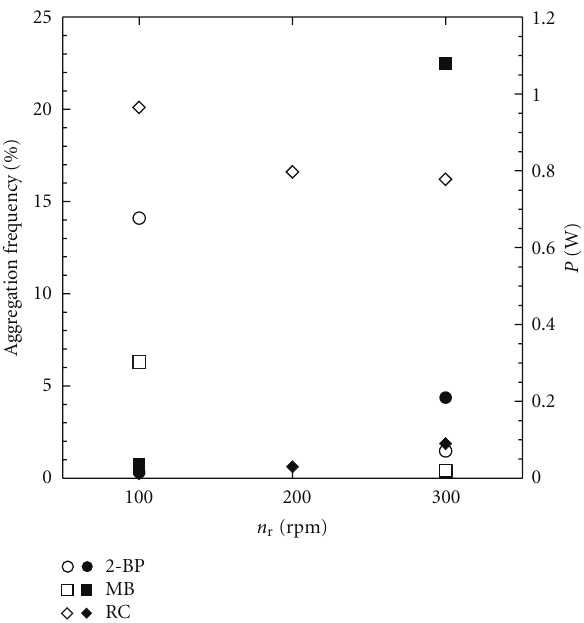
Figure 6: The aggregation frequency of hydrate particles (open symbols, left axis) and required power to agitate hydrate slurries (closed symbols, right axis) for three types of impeller.